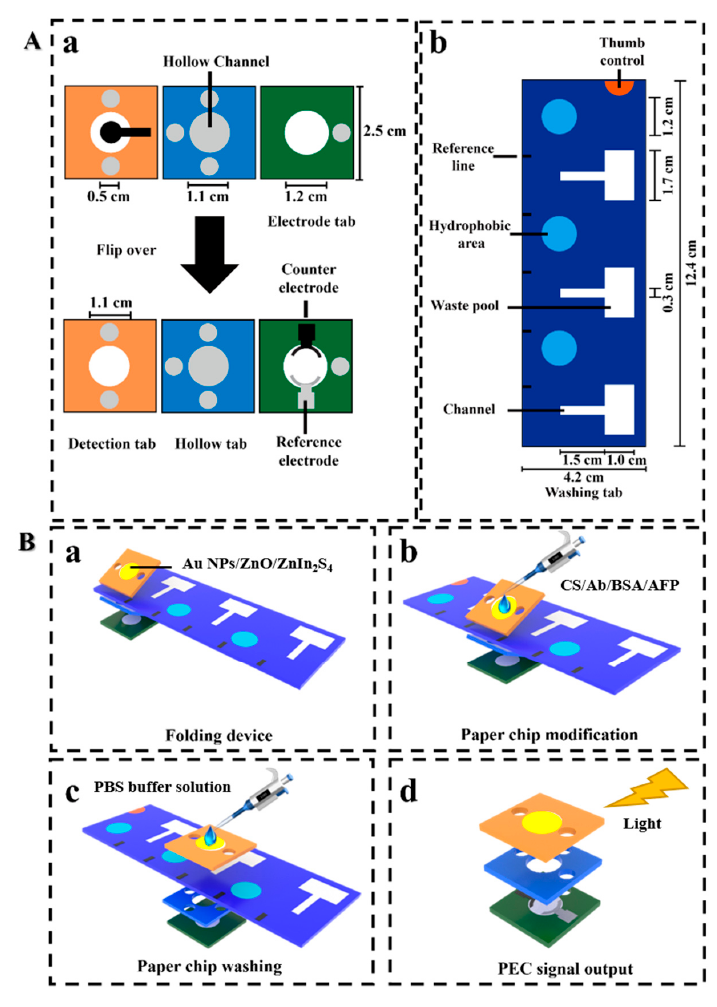
Figure 1. ( A ) The specific size and design of the μ PAD: (a) Detection tab, Hollow tab, and Electrode tab. (b) Washing tab. ( B ) Modification and PEC detection of the μ PAD: (a) Folding device. (b) Paper chip modification. (c) Paper chip washing. (d) PEC signal output.